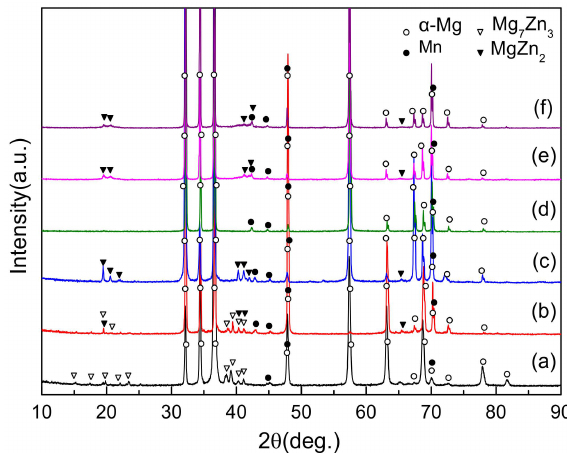
Figure 6. XRD (X-ray di ff ractometer) patterns of the ZM51 alloy under di ff erent conditions: ( a ) as-cast, ( b ) as-homogenized, ( c ) as-extruded, ( d ) T4, ( e ) T4 + single-aged and ( f ) T4 +